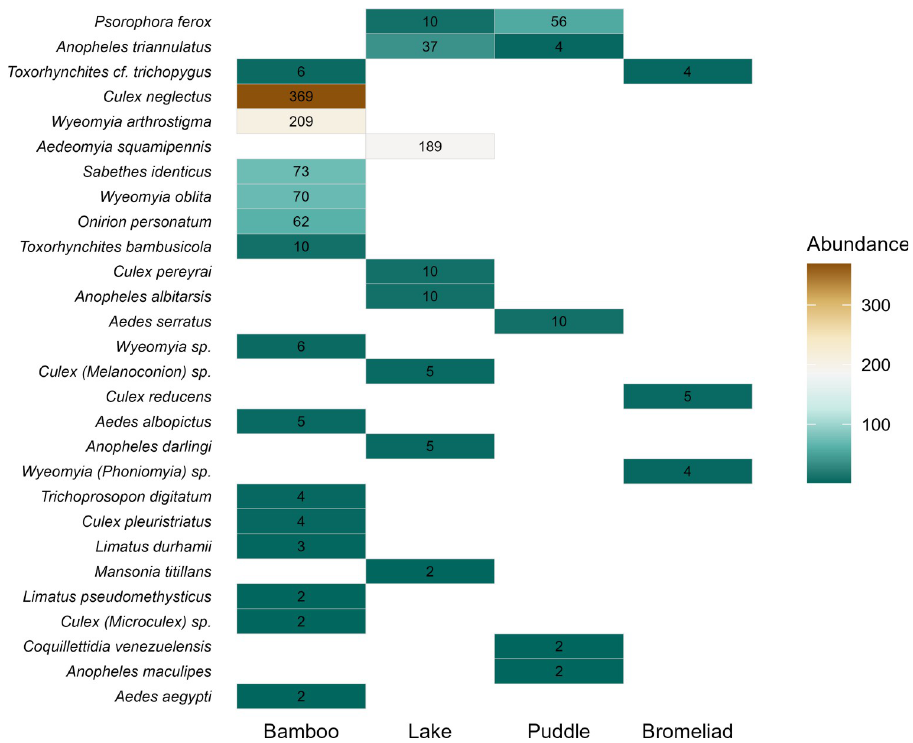
Fig 2. Species-by-site matrix for 28 mosquito species collected in four types of breeding sites in a forest fragment at the Poc¸o das Antas Biological Reserve in southeastern Brazil. Rectangles represent species occurrence in each type of breeding site and are colored according to the number of individuals found therein. Breeding sites are ordered from left to right by the number of species, and species are ordered from top to bottom by the number of sites where the species occur, followed by the number of individuals. Note that only three species occur in more than one type of breeding habitat ( Psorophora ferox , Anopheles triannulatus , and Toxorhynchites cf. trichopygus ).